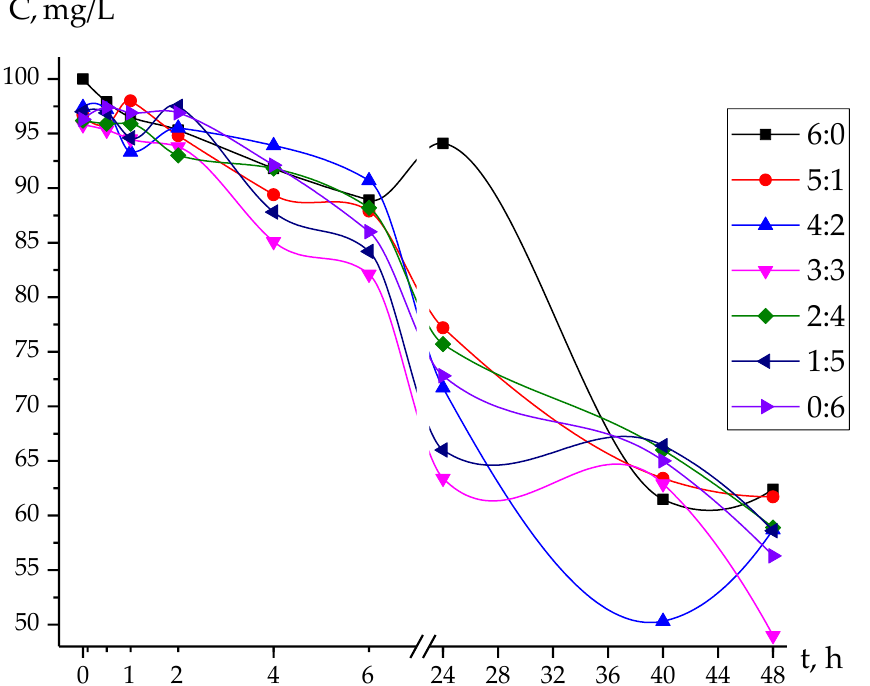
Figure 3. The residual concentration C of cerium ions in a solution after sorption as a function of time.